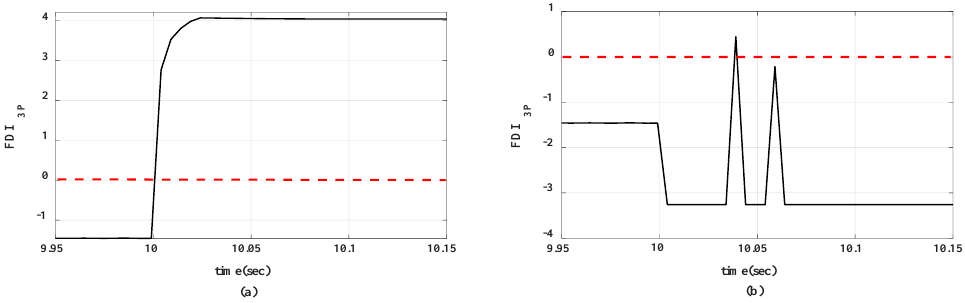
Figure 15. FDI 3P for three-phase fault with resistance 0.01 ohm in grid-connected mode at ( a ) 50% of line 4 (permanently positive) ( b ) 10% of line 5 (transiently positive).